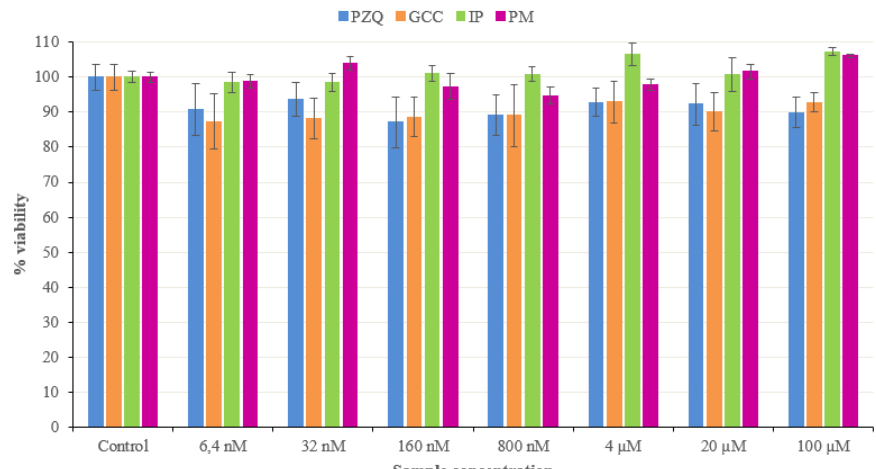
Figure 3. Cell viability from the studied samples after 48 h of treatment. (Control: untreated cells in complete medium; mean values ± standard error; n = 8).